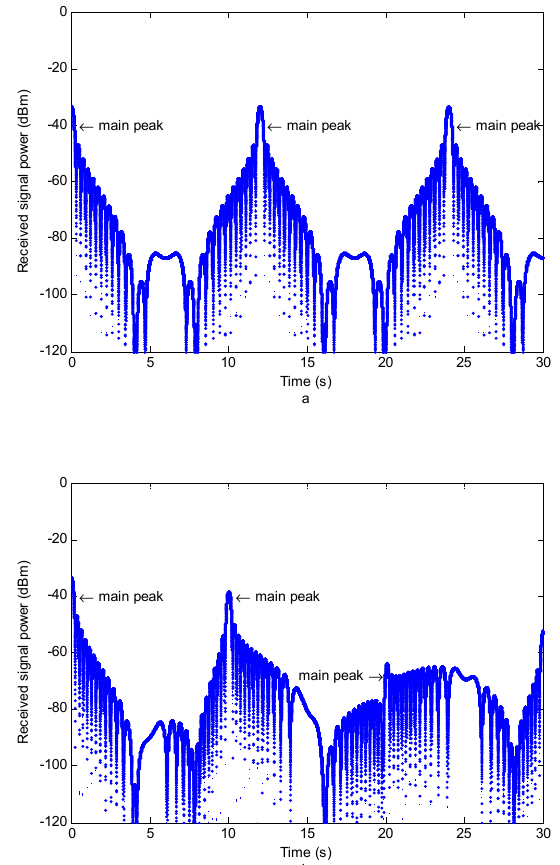
Figure 3. Received signal power of the EW system under different conditions: ( a ) received signal power for the first-row parameters in Table 1; ( b ) received signal power for the second-row parameters in Table 1. EW, electronic warfare.